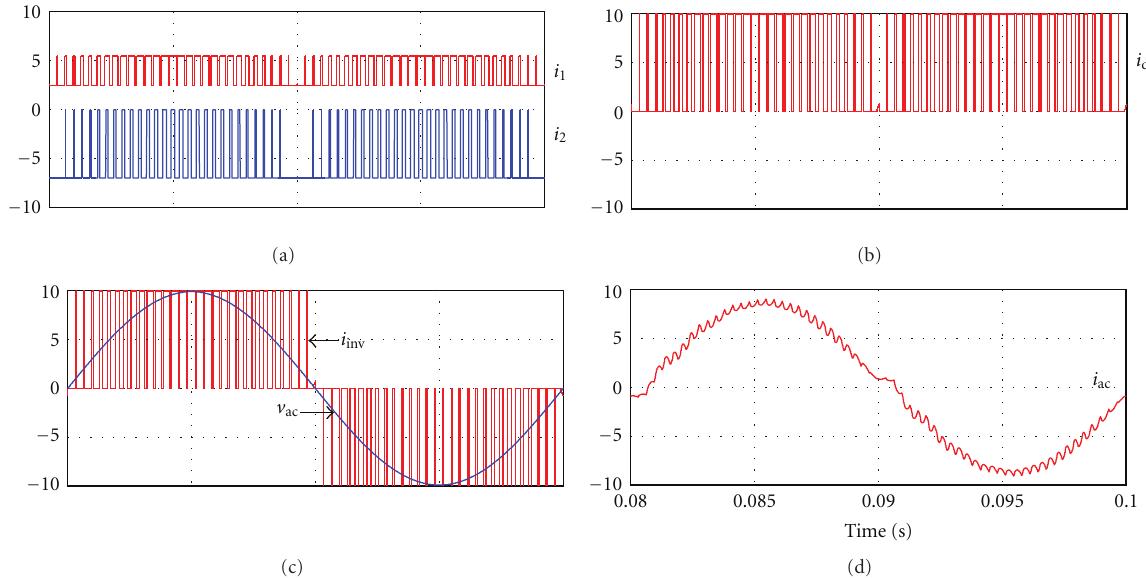
Figure 14: Operation of the system under the conditions of m pv = m wind , I pv < I wind , f line = 50 Hz and f sw = 3kHz (top to bottom) i 1 , i 2 , i dc , v i i inv , ac , and ac .